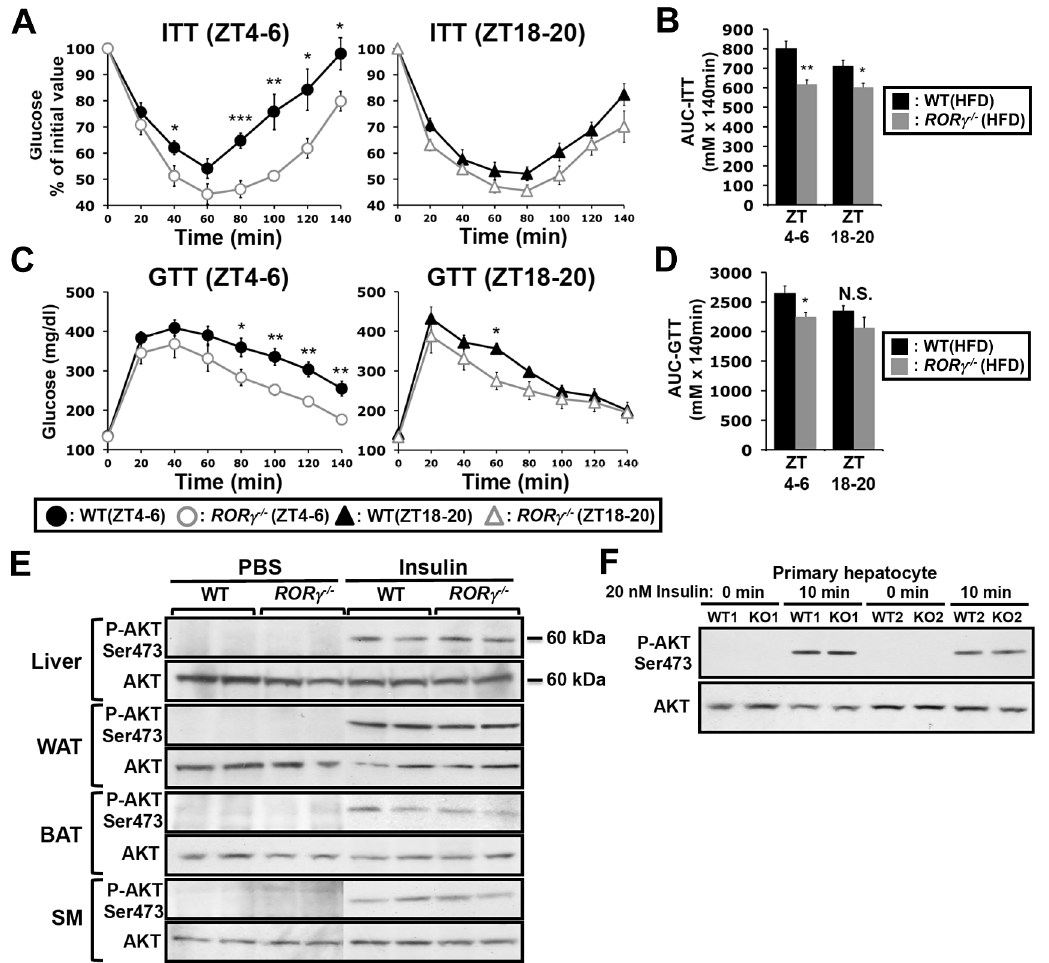
Figure 1. Loss of ROR c improves insulin and glucose tolerance in a ZT-dependent manner. ITT ( A ) and GTT ( C ) were examined at ZT4–6 and ZT18–20 in WT and ROR c 2 / 2 mice fed a HFD for 6 weeks (n=7–12). Data represent mean 6 SEM, * P , 0.05, ** P , 0.01, *** P , 0.001 by ANOVA. ( B, D ) Comparison of AUC for ITT and GTT by one way ANOVA. AUC was also calculated by 2-way ANOVA; for ITT: Time period P=0.080 and Genotype P=0.0002; for GTT: Time period P=0.073 and Genotype P=0.013 (not shown). ( E ) Loss of ROR c did not affect Akt activation. Total and phosphorylated of Akt were examined by Western blot analysis in liver, BAT, WAT, and skeletal muscle (SM) isolated from WT(HFD) and ROR c 2 / 2 (HFD) mice 30 min after intraperitoneal injection of either 0.75 U/kg insulin or PBS. ( F ) Representative Western blot analysis (n=2) of total and phosphorylated Akt in primary mouse hepatocytes isolated from WT and ROR c 2 / 2 mice. Cells were treated with 20 nM insulin or PBS for 10 min before proteins were